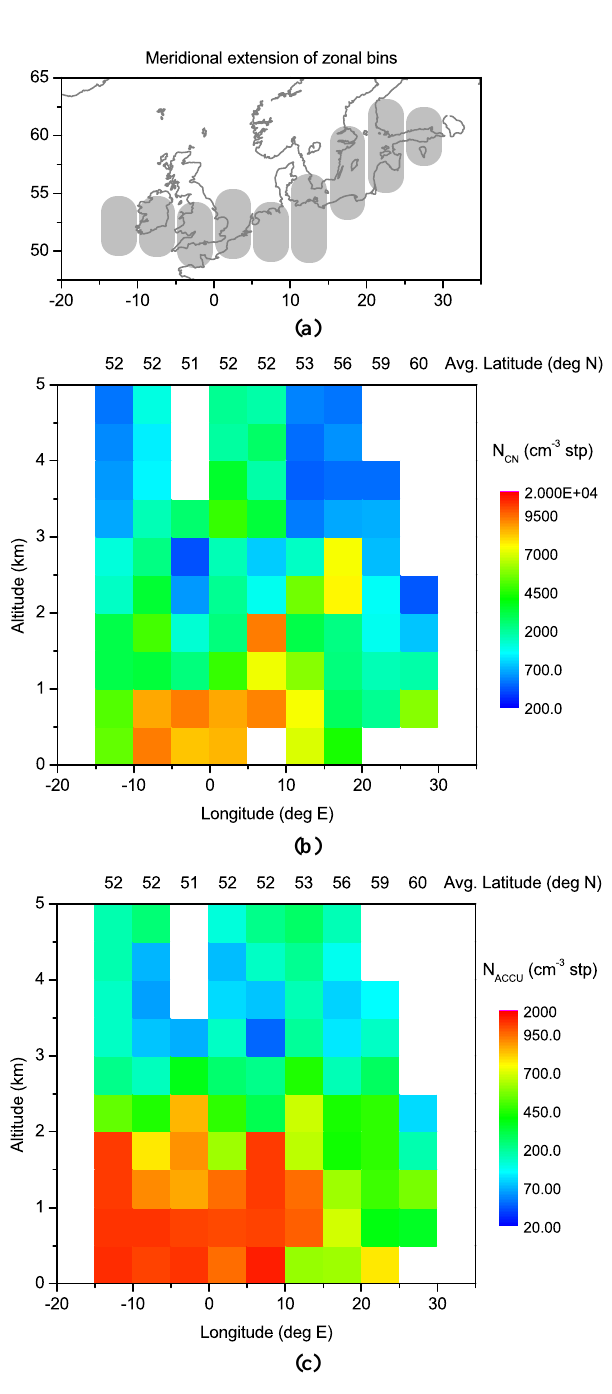
Fig. 4. Zonal distribution of binned vertical profiles (a) of CN (b) and ACC (c) number concentrations North of 50 ◦ N derived from DLR Falcon 20 and FAAM BAe-146 measurements. Please note the variable average latitude of the measurements and the logarithmic colour